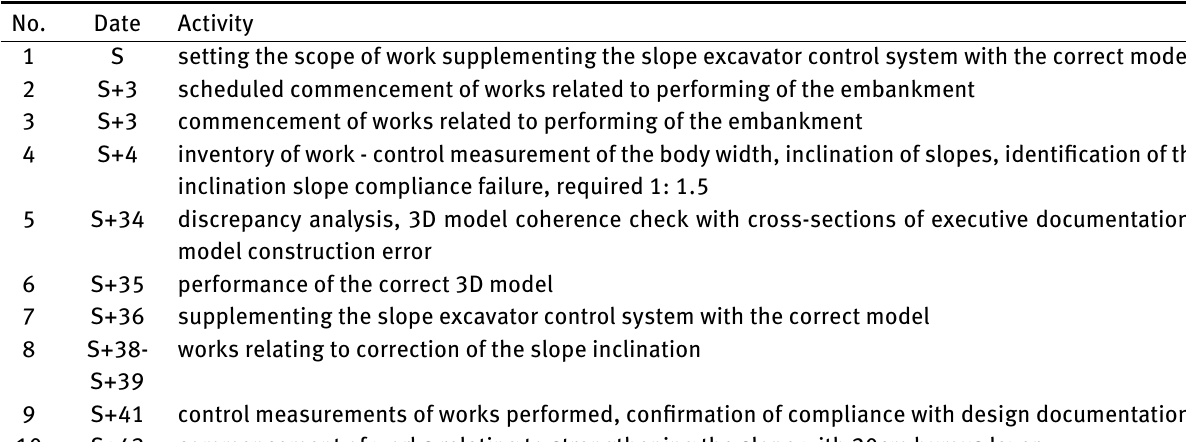
Table 5: Separate part of the schedule in which the R5 factor occurred, Source: own elaboration.